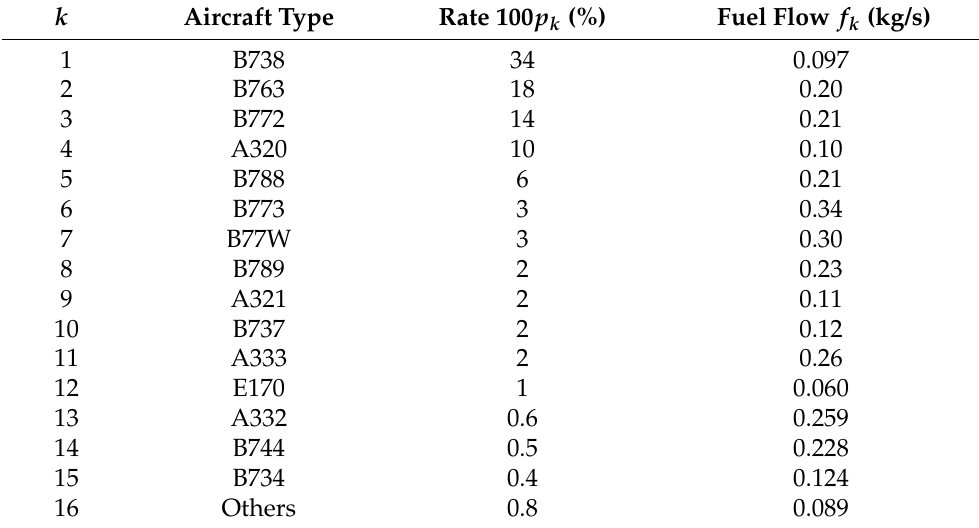
Table 4. Aircraft types, rate, and fuel consumption per engine [21].